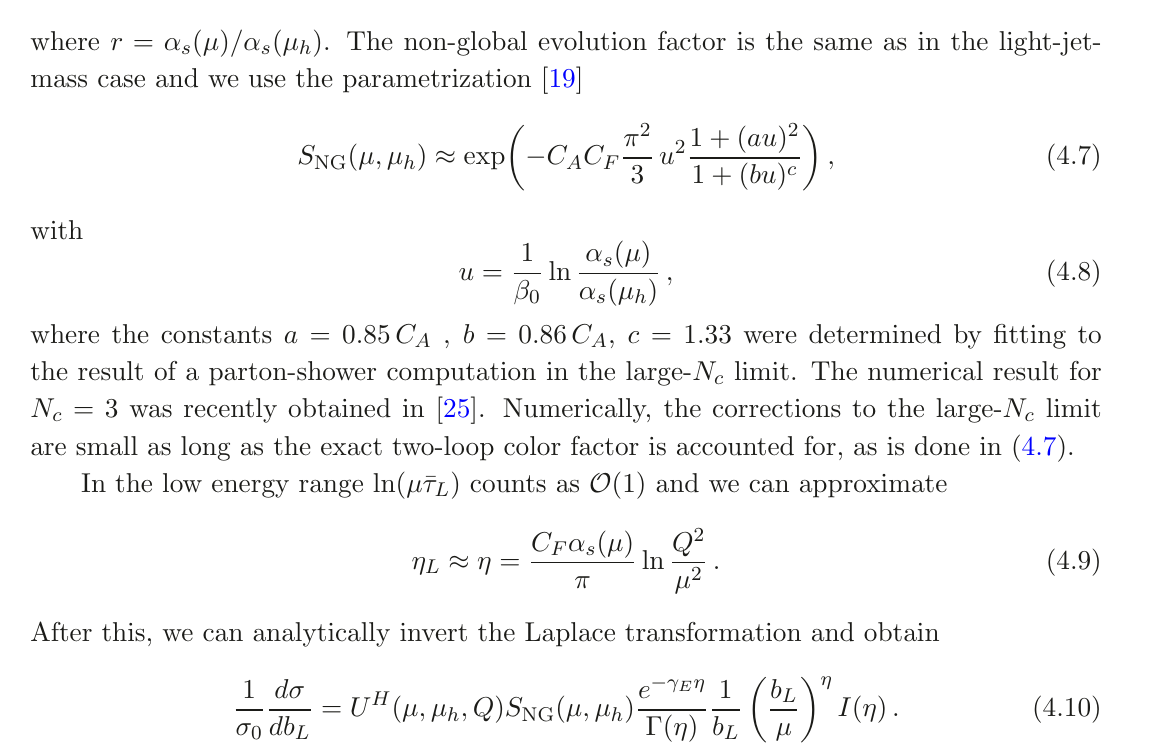
Figure 1 . The red bands show the NLL result for the narrow broadening (left) and the wide broadening (right), compared to Delphi data (blue) [29]. The green line is the purely global part of the narrow broadening